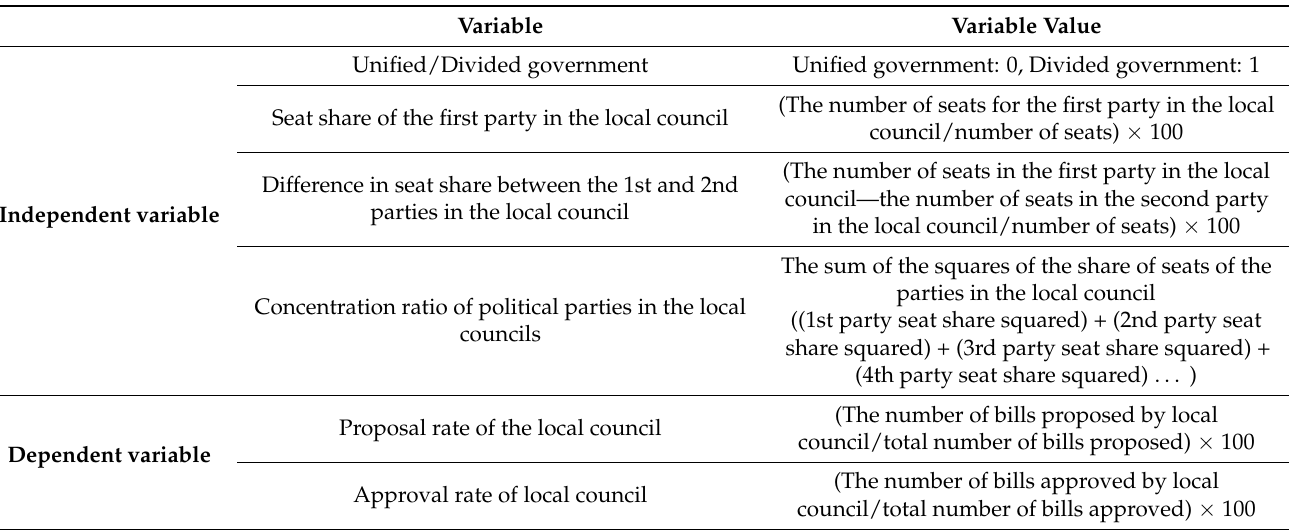
Table 2. Variable list and variable